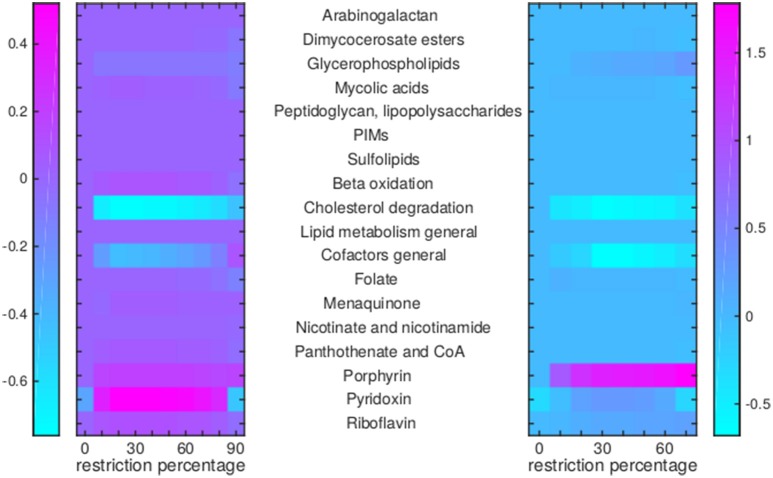
Flux rerouting through cell wall component metabolism, lipid metabolism, and cofactor metabolism upon application of drugs. Heat maps indicate a predicted relative increase (pink) or decrease (light blue) through various pathways upon the application of a variety of drugs. The logarithm of the sum of all absolute fluxes is given per pathway (values are indicated in the color bars on either side), so information on directionality is not comprised. The x-axis indicates the percentage of restriction of the drug-affected reaction(s). Left: average of BTZ043, cycloserine/terizidone, ethambutol, ethionamide/propionamide, and isoniazid; Right: TMC207.